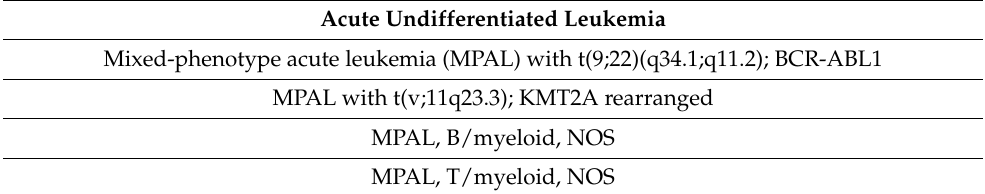
Table 2. WHO 2016 criteria for acute leukemia of ambiguous